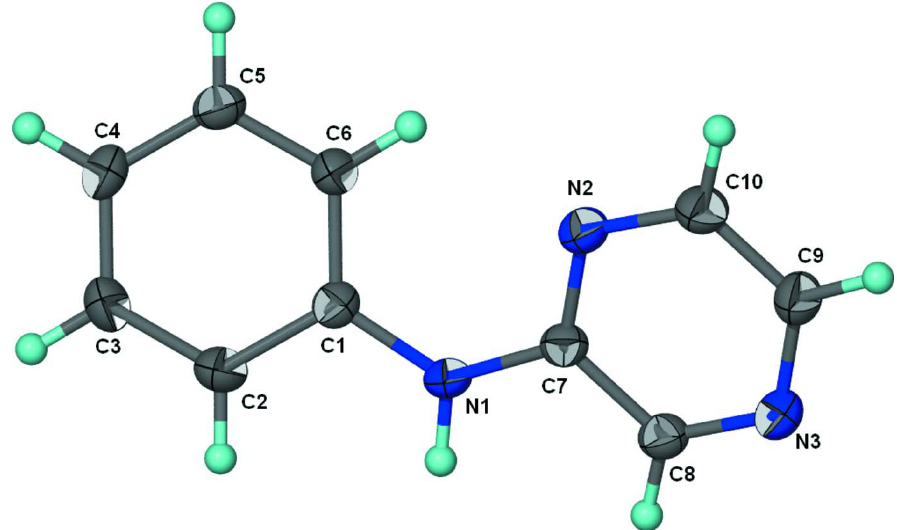
H N at the 70% probability level; hydrogen atoms are drawn as spheres of 10 9 3